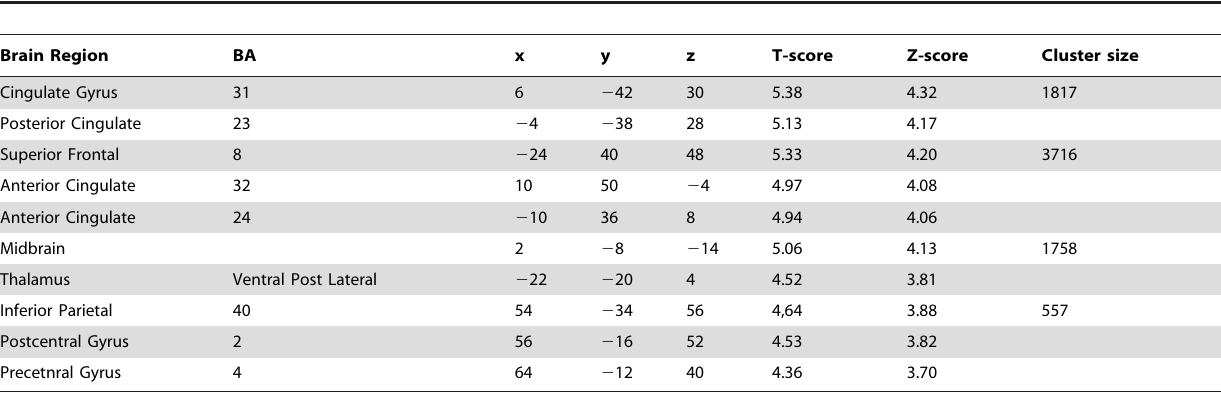
Table 1. Clusters where the SPM analysis done on the normalized metabolic images showed significant changes (Neutral . Cocaine-cues) for the female participants (p c . 0.05, cluster . 200 voxels) after covarying for amount of cocaine used (daily